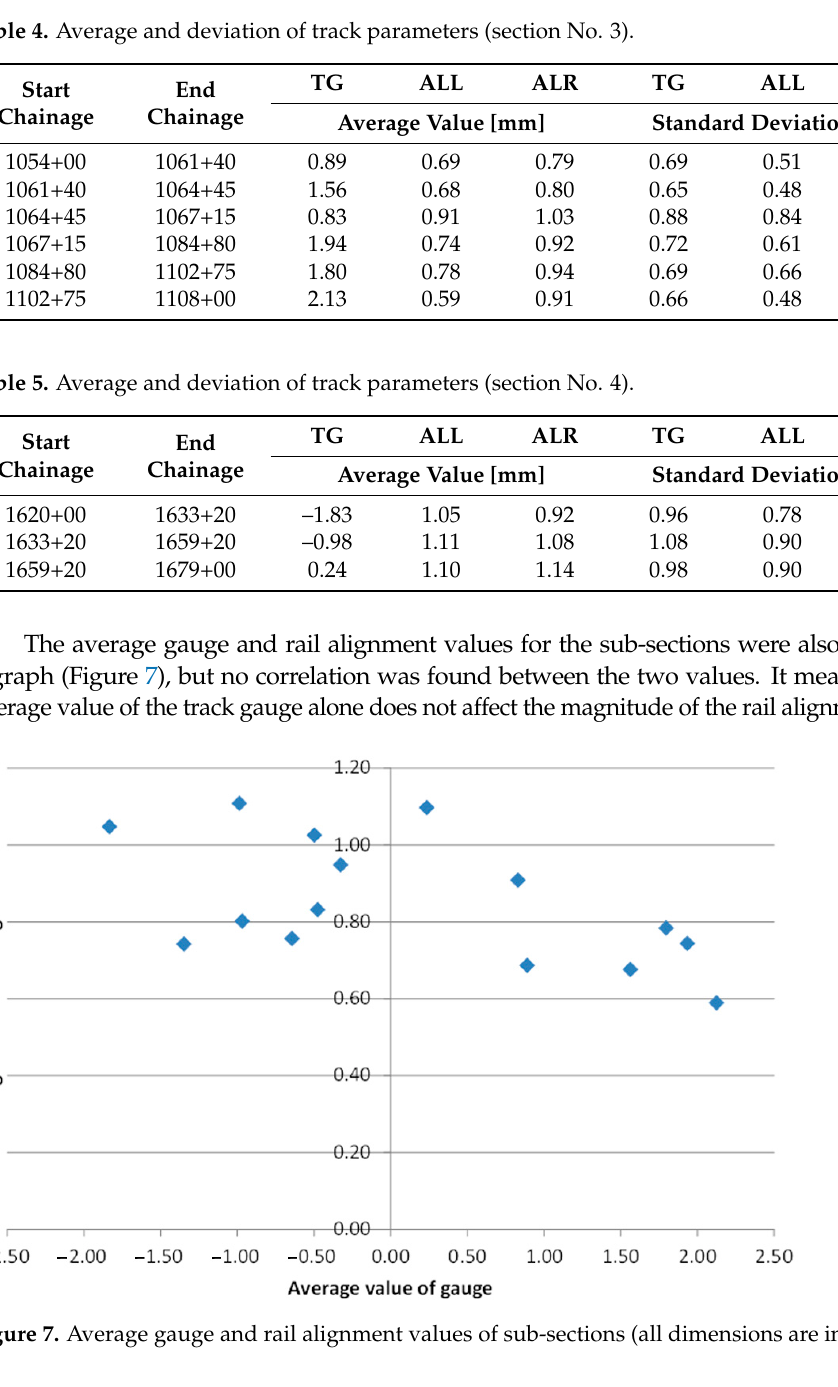
Table 4. Average and deviation of track parameters (section No. 3).